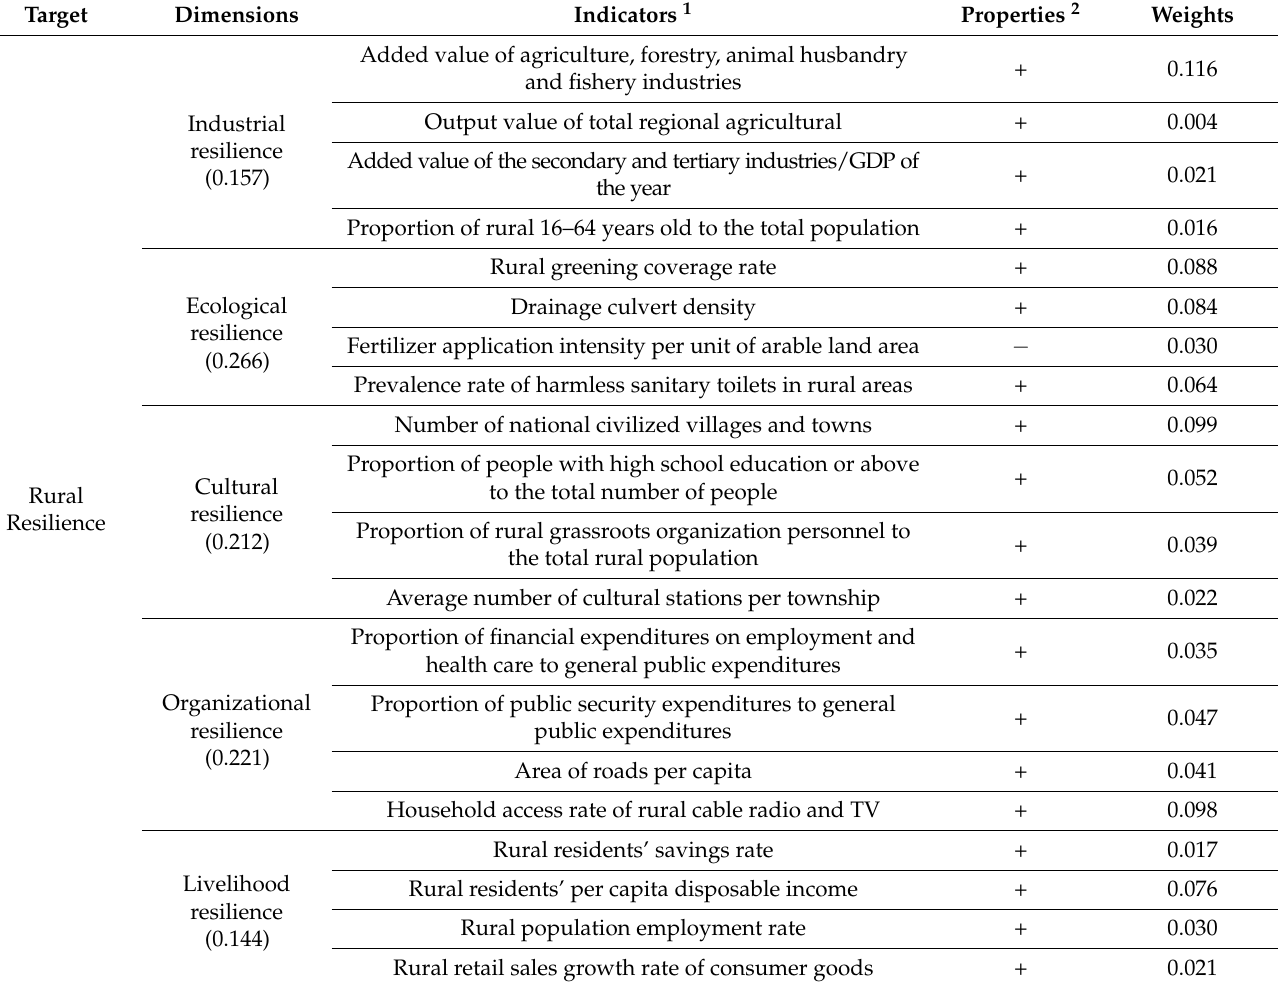
Table 1. Rural resilience evaluation index